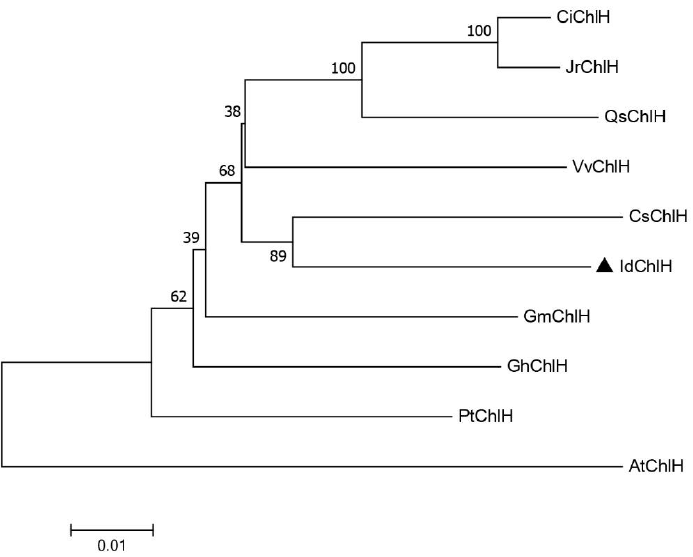
Figure 2. Phylogenetic analysis of IdChlH (black triangle) and ChlH proteins from other species. The accession numbers of the proteins are CsChlH (AEI83420.1), CiChlH (XP_042945153.1), VvChlH